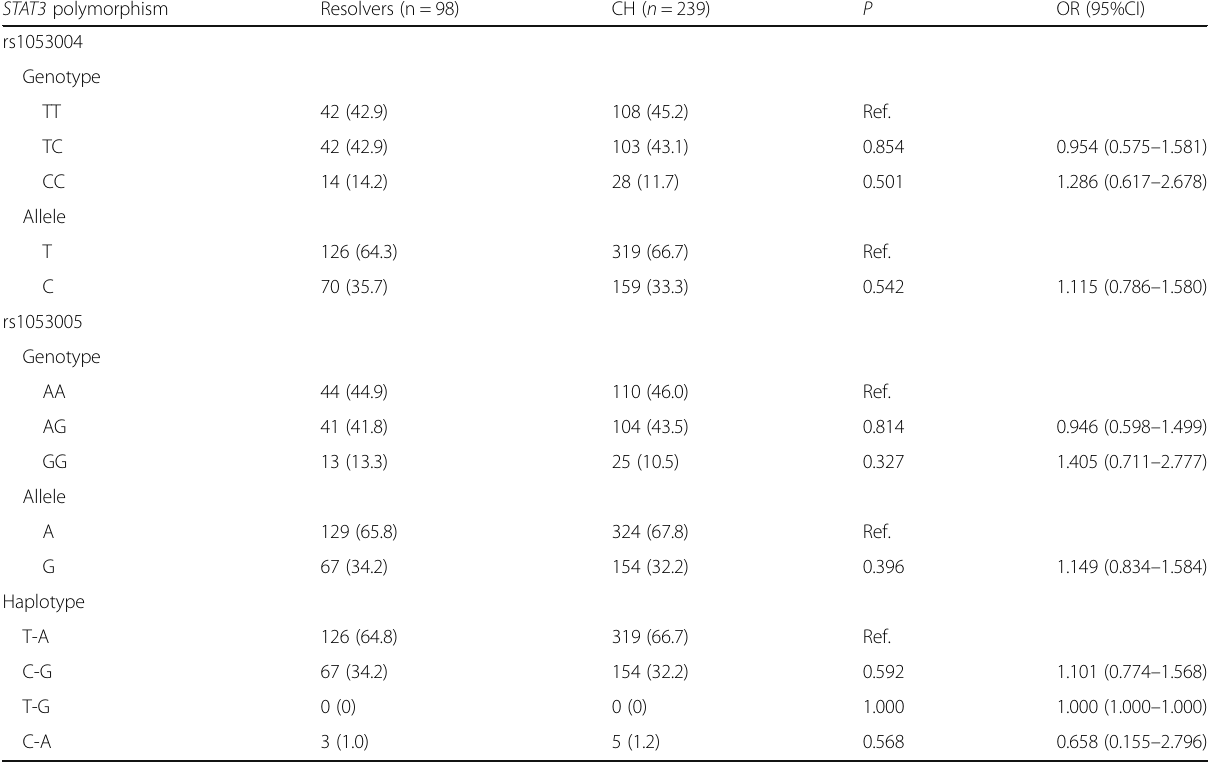
Table 3 Genotype, allele and haplotype (rs1053004-rs1053005) frequencies of STAT3 rs1053004 and rs1053005 polymorphisms in hepatitis B virus infection resolvers and patients with chronic